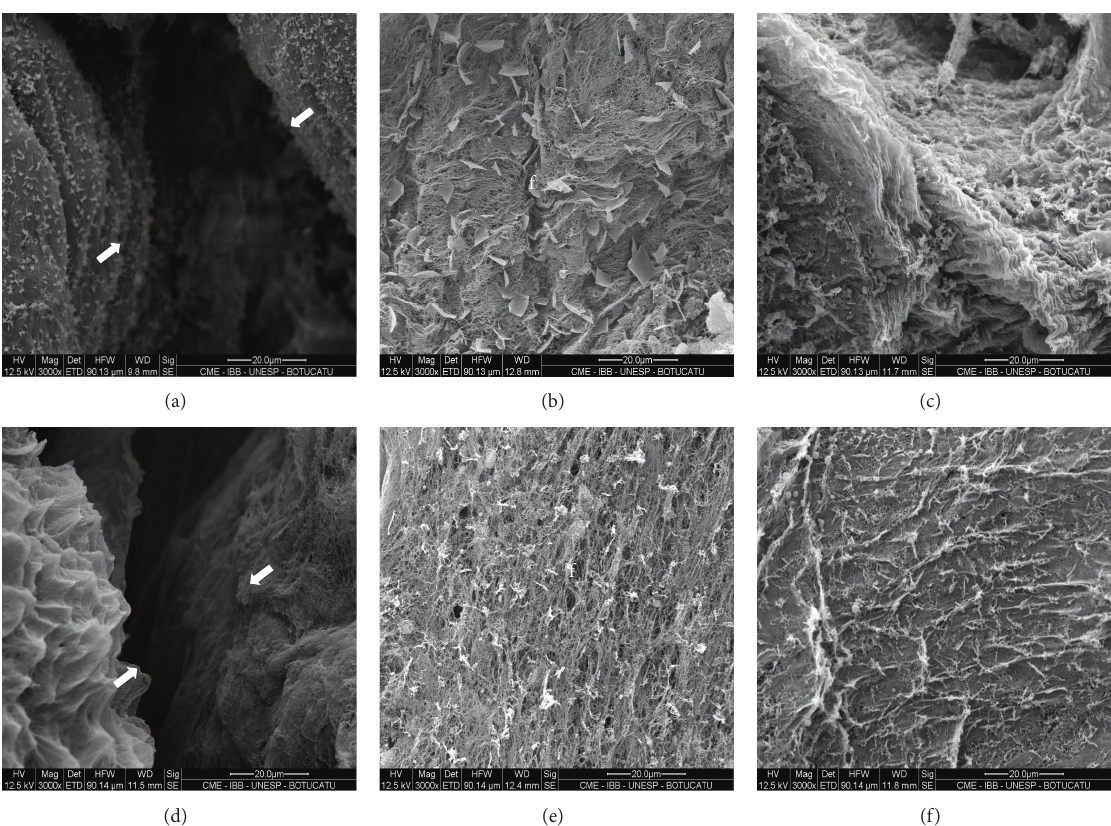
Figure 5: Photomicrographs of surgical scars from the skin of normal rat ((a), (b), and (c)) and diabetic ((d), (e), and (f)), sacrificed on postoperative day 7. Note that the process of reepithelialization of incisional surgery wounds is still incomplete (arrows) in rats of NG/NT and DG/NT, the largest increase ((a) and (d)). Note the disorganized collagen deposition thin, with multiple fenestrations (f) in NG and DG rats with incisions treated with CEC alone ((b) and (e)) compared with the deposition of dense collagen with few fenestrations observed in mouse NG and NG with incisions treated with Zn + TDI ((c) and (f)) (ME -